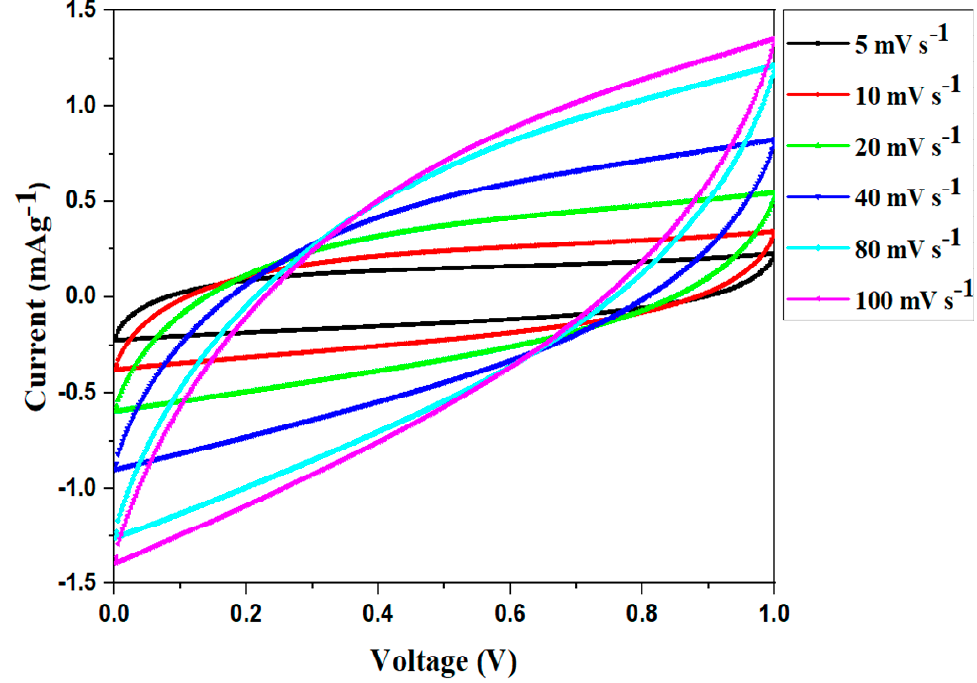
Figure 7. CV pro fi le of the fabricated EDLC at di ff erent scant rates. Figure 7. CV profile of the fabricated EDLC at different scant